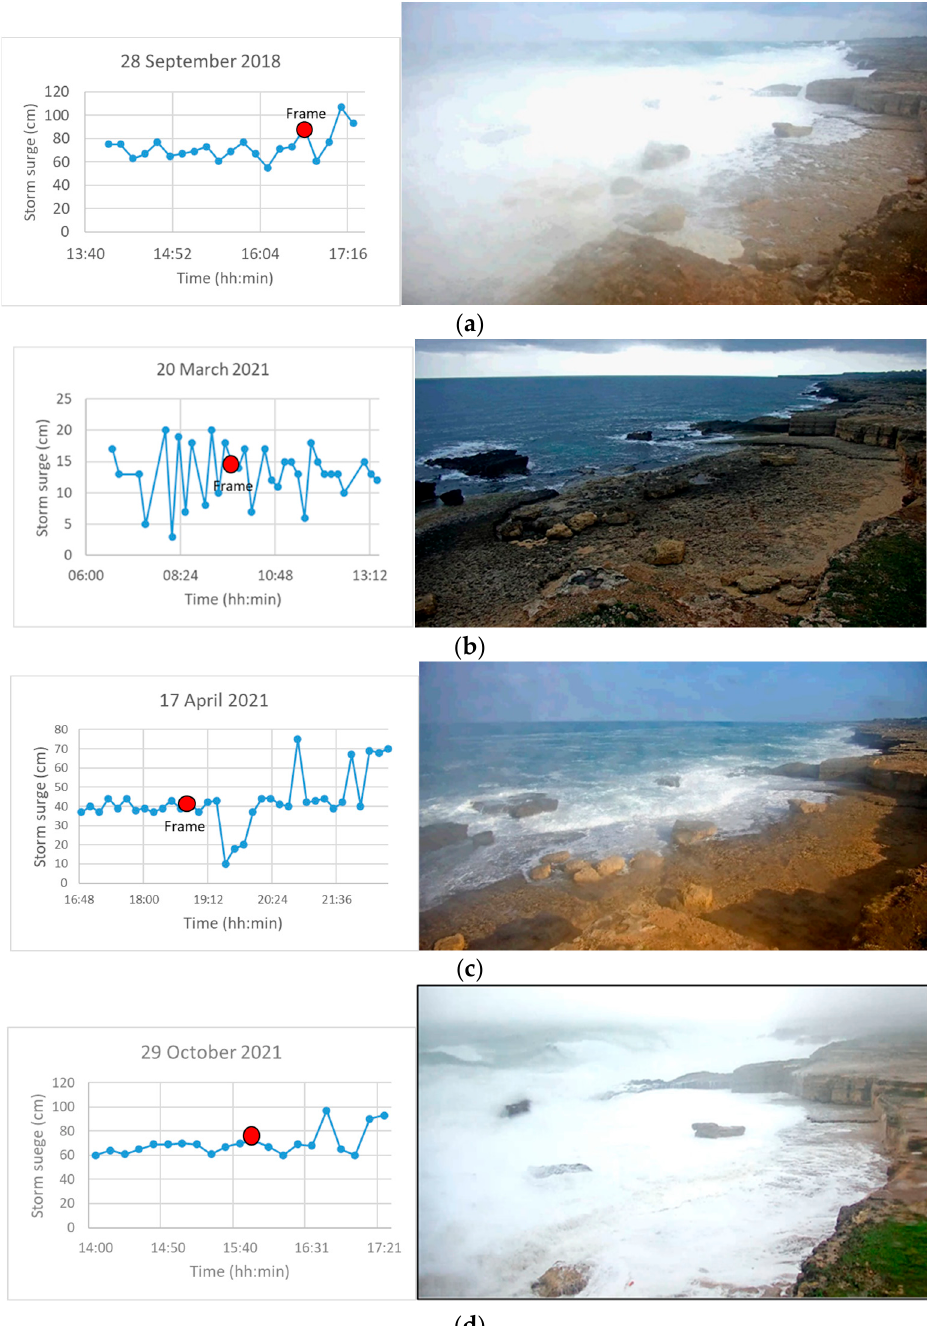
Figure 12. Storm surge assessed through CNN in Santa Lucia; ( a ) storm surge values of medicane Zorbas (28 September 2018); ( b ) storm event of 20 March 2021; ( c ) storm event of 16 April 2021; ( d ) medicane Apollo (29 October 2021).